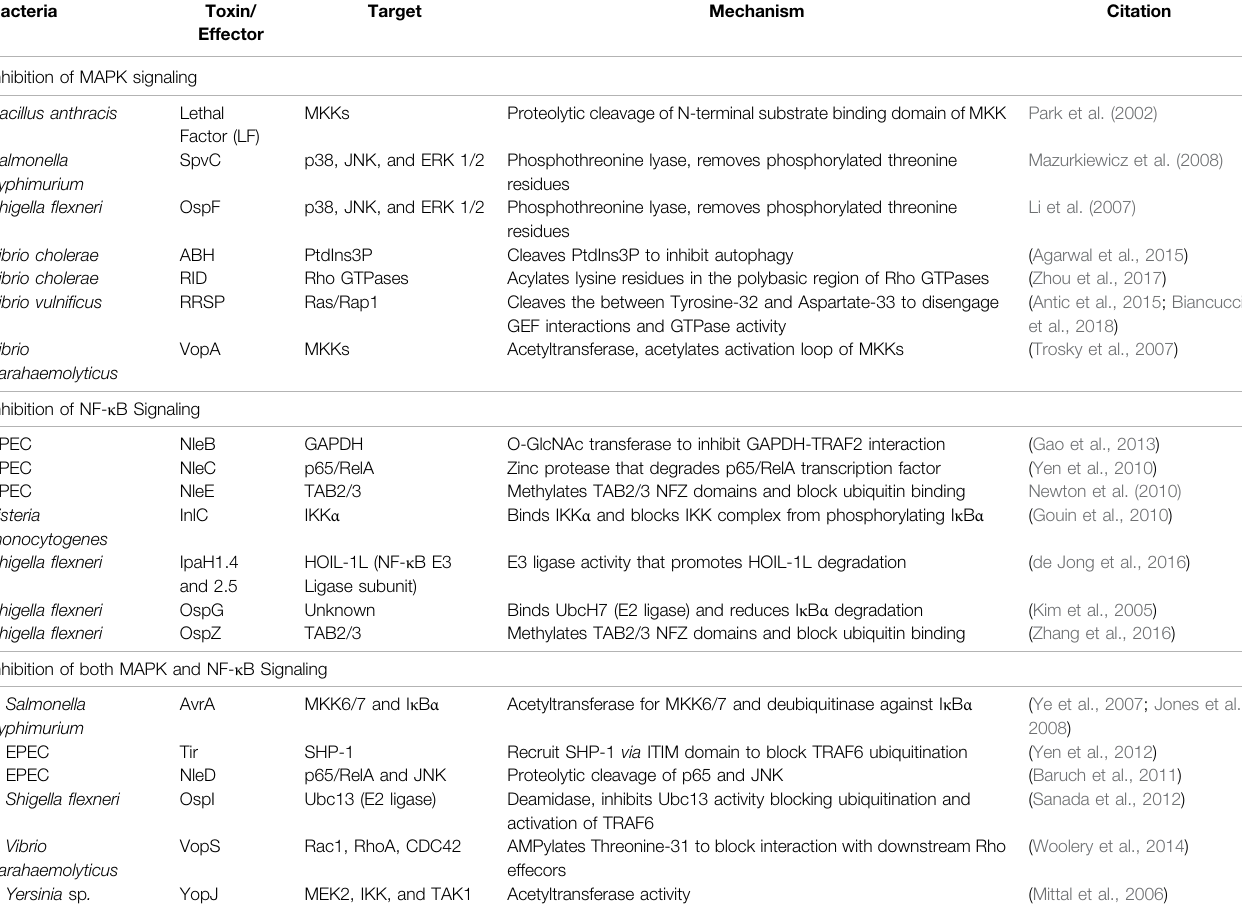
TABLE 1 | Toxins and effectors that inhibit MAPK and NF- κ B pathways.